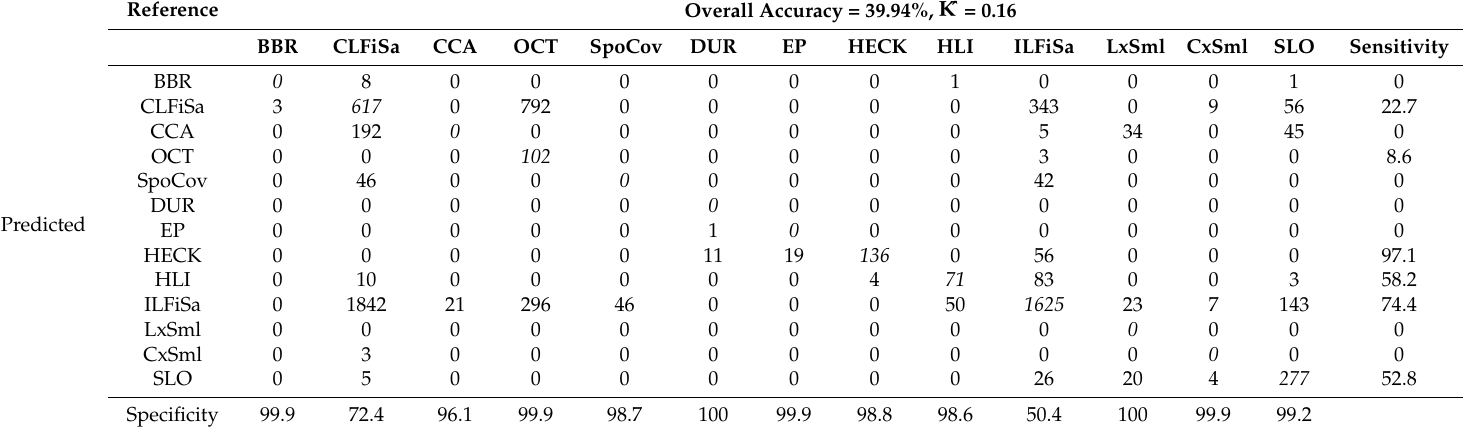
Table 6. Error matrix for BC4. Class codes are as follows: High-energy Durvillaea communities (DUR); High-energy Ecklonia communities (HECK); High-energy Ecklonia-Phyllospora communities (EP); High-energy lower infralittoral zone (HLI); Bushy bryozoan-dominated communities (BBR); Crustose coralline algal communities with combinations of thallose red algae and scattered sponges on high-energy circalittoral rock (CCA); High-energy circalittoral rock with seabed covering sponges (SpoCov); Low complexity circalittoral rock with non-crowded erect sponges (LxSml); Moderate-to-high complexity circalittoral rock with prominent sea plumes, sea tulips and hydroid fans (PSH); Moderate-to-high complexity circalittoral rock with seabed covering sponges (SpoCov); Sandy low-profile reef wave surge communities with sand trapped around sponges (SLO); Erect octocorals on sediment (OCT); Circalittoral fine sand (CLFiSa); Infralittoral fine sand (ILFiSa). Italicized values indicate correctly classified